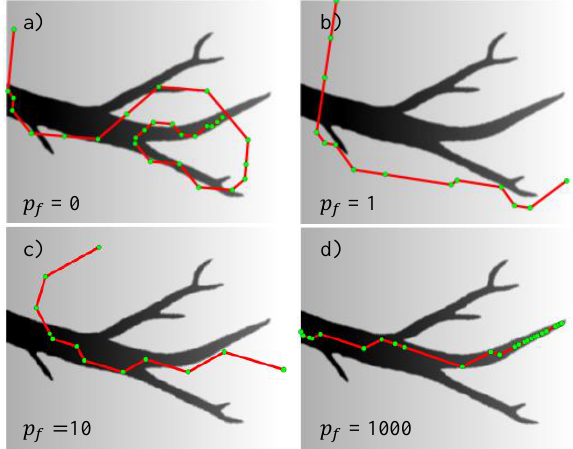
Figure 6. Excluding the data term results in the construction of connected graphs which only consider data via the prior term for the flow direction. Increasing the corresponding penalising factor p f , the graph better and better approximates the channel network.